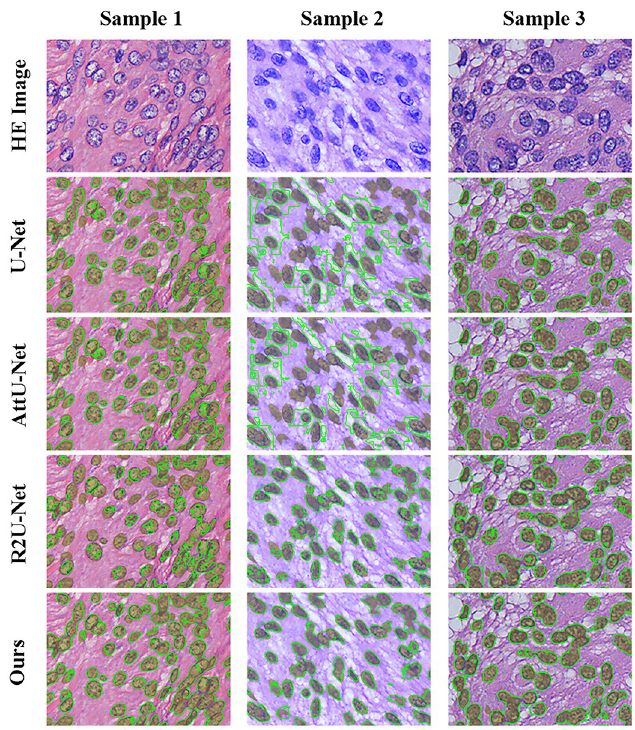
Fig 7. Comparison of the segmentation results with supervised semantic segmentation methods. Each row represents the segmentation results of different methods, and each column represents different samples. The olive areas in the image represent ground truth, and the green line represents the result of nuclear segmentation using the corresponding method.